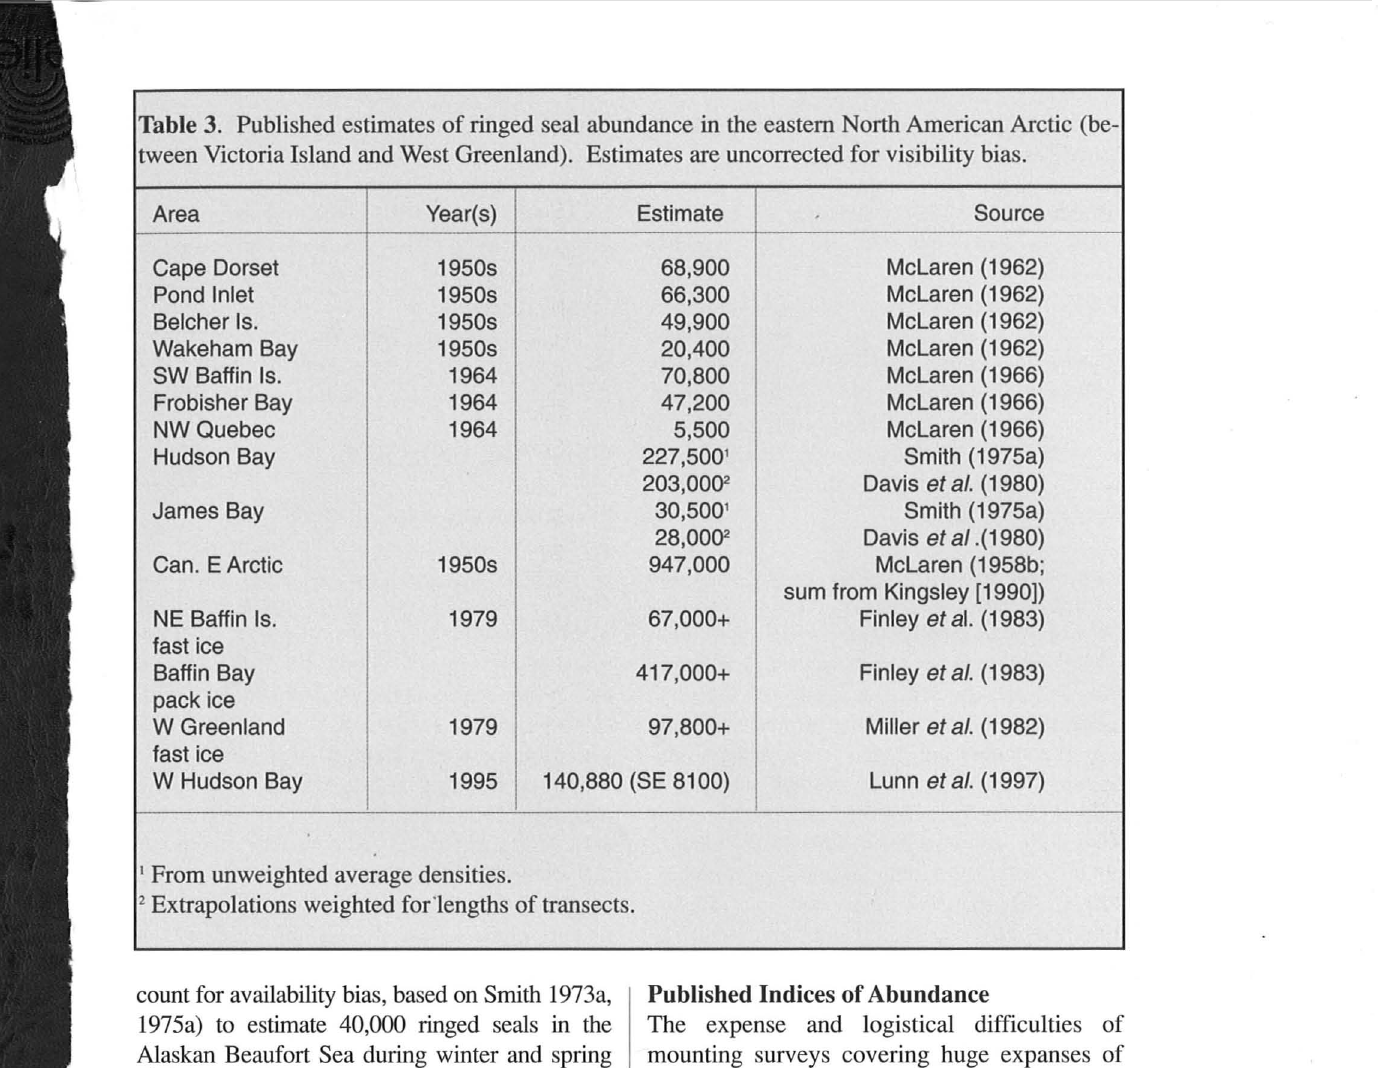
Table 3. Published estimates of ringed seal abundance in the eastern North American Arctic (be- tween Victoria Island and West Greenland). Estimates are uncorrected for visibility